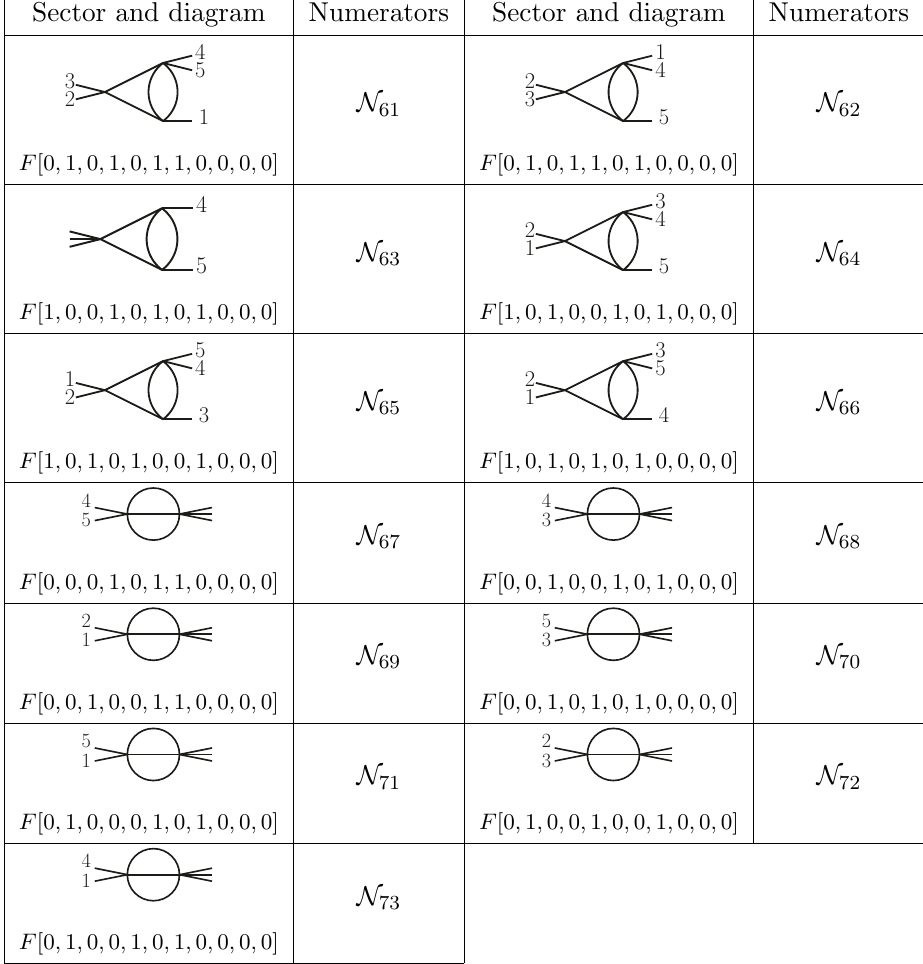
Table 3 . Diagrammatic representation of each sector and associated numerators. Open